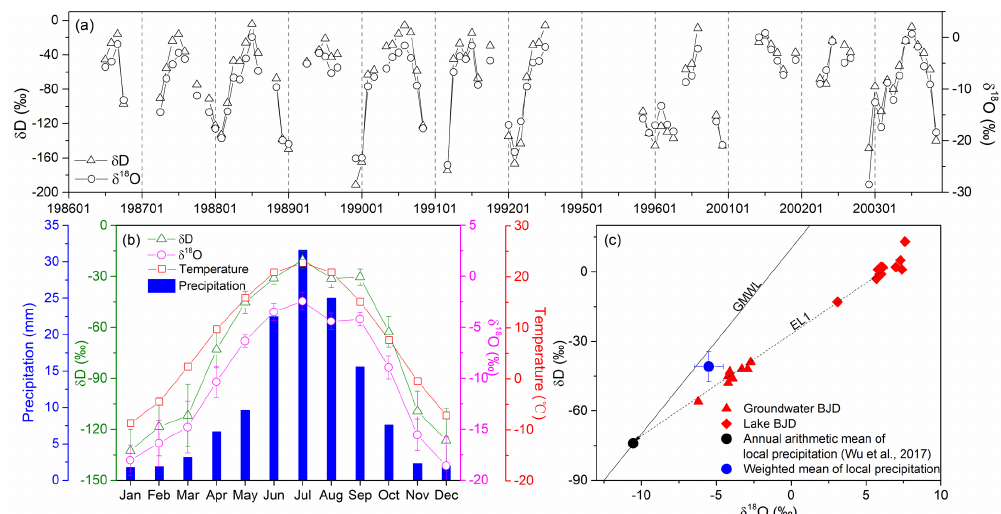
Figure 1. Isotope composition of monthly precipitation of GNIP station Zhangye (all available datasets a , and monthly mean values b ), and δ D– δ 18 O plots of groundwater, lake water and annual precipitation in the study area (based on data from Zhangye station) (c) . Data in (a) and (b) are sourced from the GNIP database, while plot (c) is modified from Wu et al. (2017). Statistical mean values are shown together with standard errors where